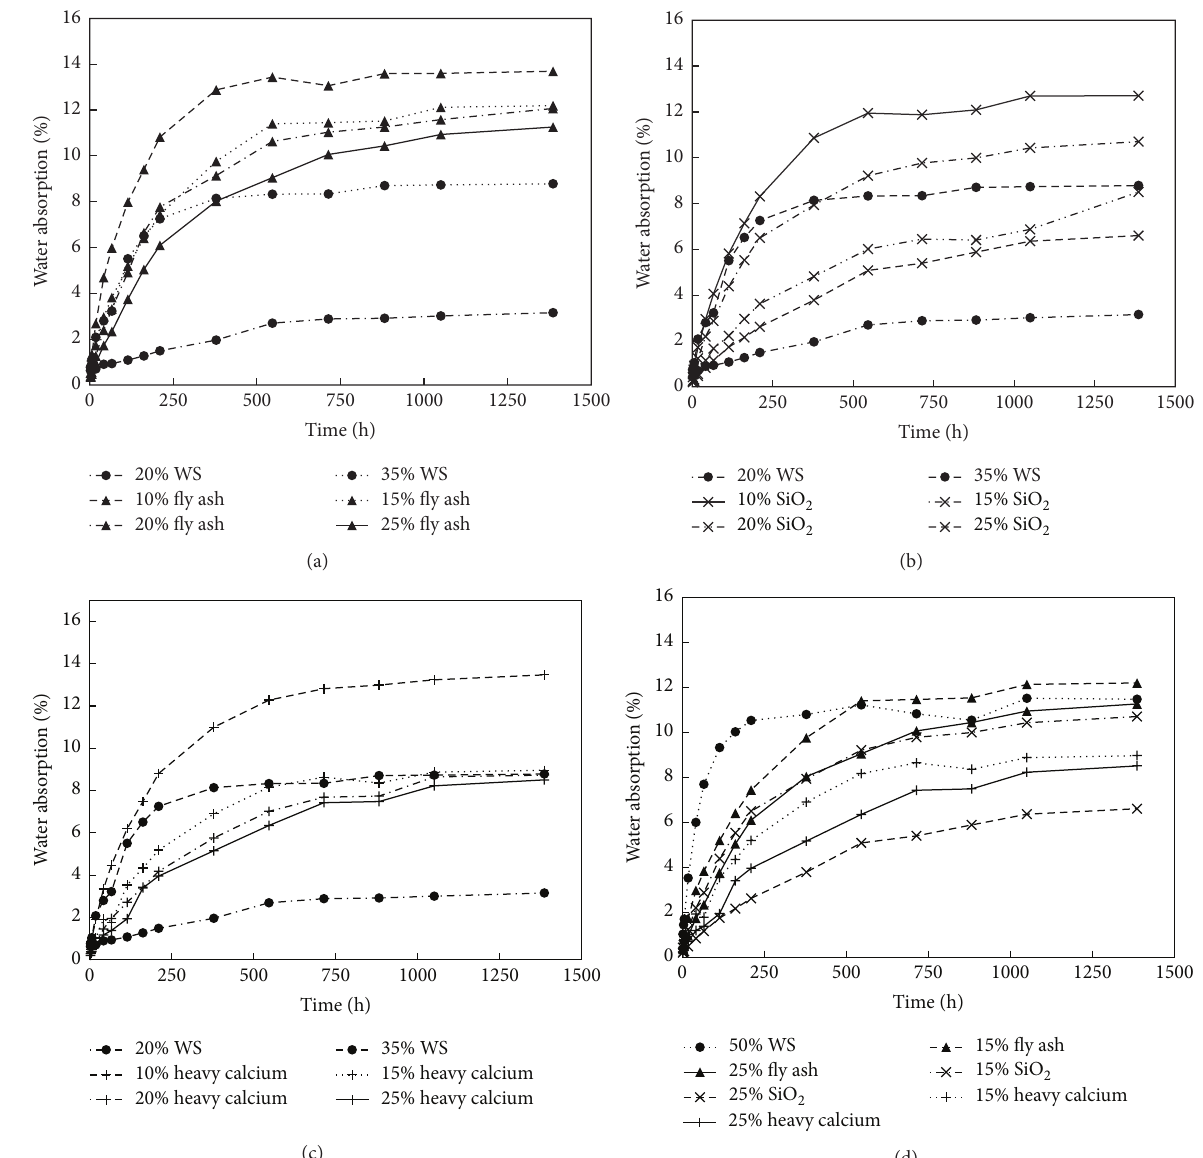
Figure 4: Water absorption of WS and inorganic filler reinforced PP